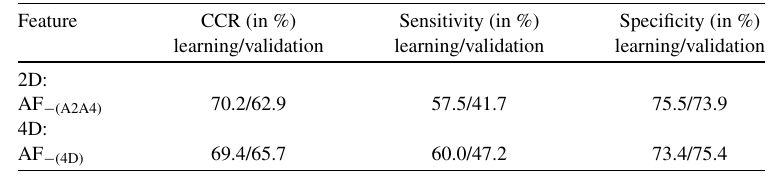
The learning and validation set correct classification rate (CCR), sensitivity and specificity for the “best” single feature extracted from either 2D entropy matrices or 4D patient matrices